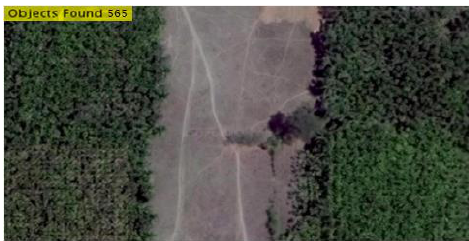
Figure 10 Frames from video with predicted count of (a) 32, (b) 0, (c) 4, and (d) 845 trees